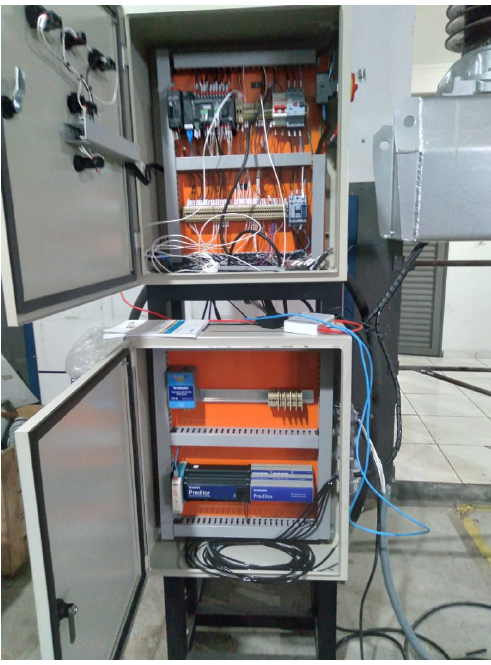
Figure 5. Preditor 4.0 acquisition